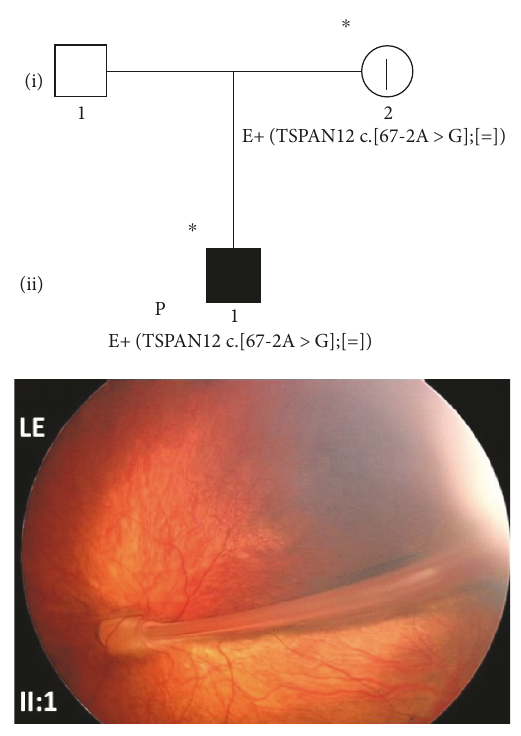
Figure 6: Pedigree and ocular features of family 6. RetCam color fundus photograph from the LE of the 7 y/o male proband (II:1) of family 6, showing FEVR stage 3A for the presence of a falciform retinal fold arising from the optic nerve head, involving the macula and anchored in the temporal periphery without signs of exudation. ∗ Documented clinical evaluation; E+ and E − , positive and negative to genetic test, respectively. | Asymptomatic/ presymptomatic carrier (stage 1 FEVR); LE, left